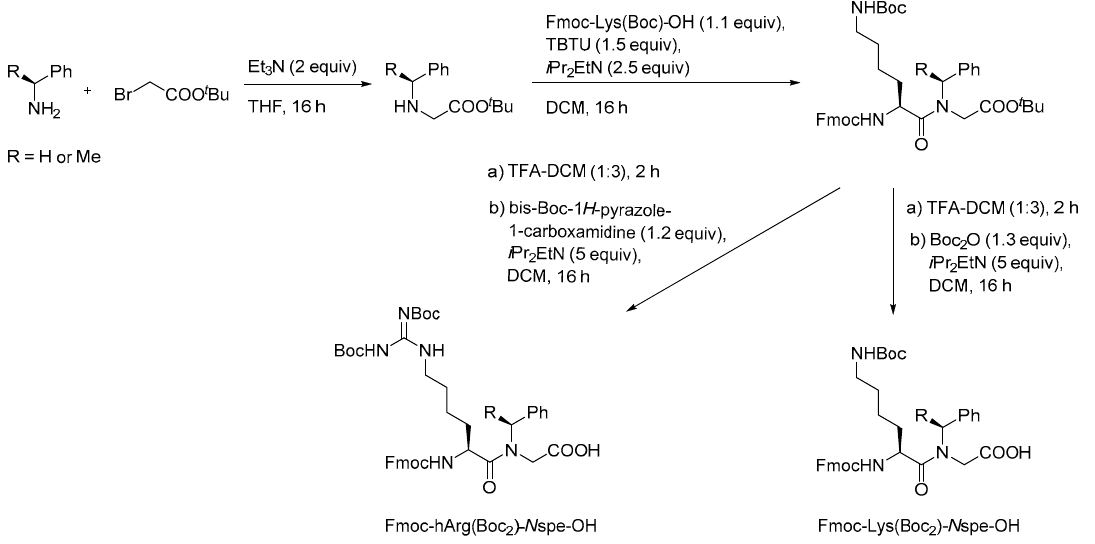
Scheme 11. Synthesis of α -peptide/ α -peptoid dimeric building blocks [120].